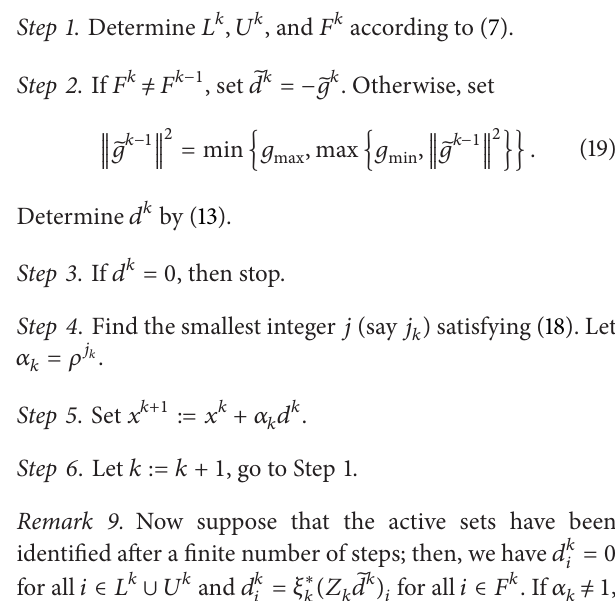
Algorithm 8 ( SDPRP ). The steps of the algorithm is given as